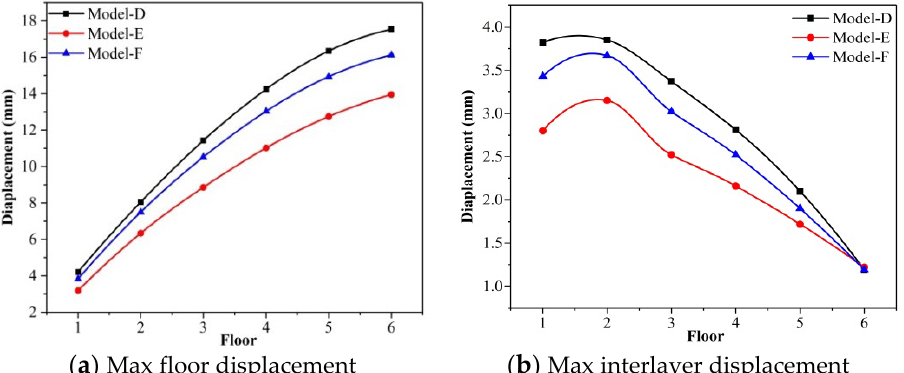
Figure 9. The floor displacement and interlayer displacement in the X-direction.